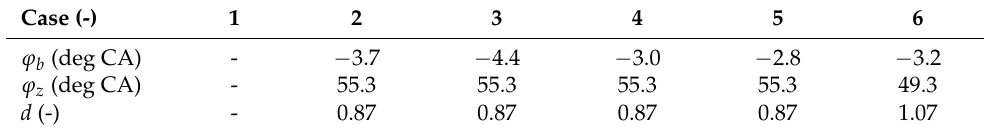
Table 12. The Wiebe parameters according to the WA model in fuel sharing mode. Case (-)